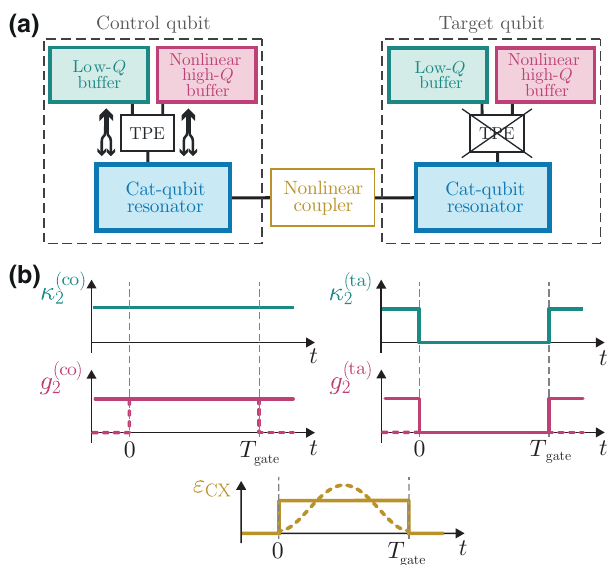
FIG. 10. (a) Circuit schematic of a cat-qubit CNOT gate using a combined two-photon dissipation and TPE Hamiltonian con- finement scheme on both qubits. The control cat-qubit resonator is connected to the target cat-qubit resonator through a nonlin- ear coupler that engineers the feedforward Hamiltonian of Eq. (14). During the CNOT gate, both Hamiltonian and dissipative confinements are turned off on the target qubit by turning off the pump of the TPE element. (b) Amplitudes of the different dissi- pation and Hamiltonian terms during the CNOT gate. A constant feedforward Hamiltonian amplitude with first-order correction is assumed in full lines. Vertical dashed lines identify gate start and end times, while dashed curves show alternative approaches. More precisely, while the TPE confinement of the control cat qubit is essential during the operation of the gate to ensure a gate acceleration, it can be turned off during the idling time. Keeping it on can however be useful for compensating spurious Hamil- tonian perturbations. Concerning the feedforward Hamiltonian, while simulations are performed with a constant amplitude, it is possible to benefit from superadiabatic pulse designs to further accelerate gates, similarly as in Ref.